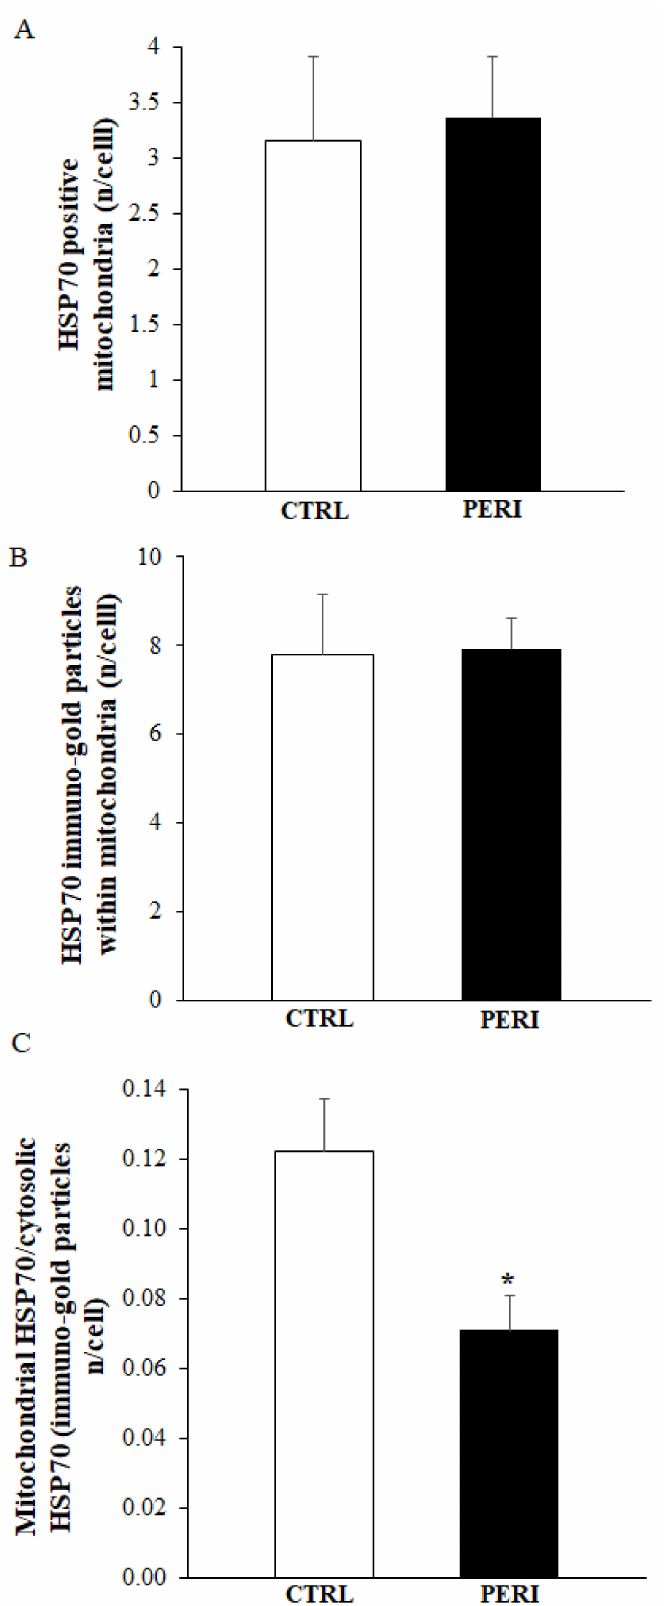
Figure 10. Polarization graphs for HSP70 within mitochondria in the ventral cerebral cortex. Graphs report the HSP70-positive mitochondria ( A ), the HSP70 immuno-gold particles within mitochondria ( B ) and the ratio of mitochondrial to cytosolic HSP70 immuno-gold particles ( C ). * p ≤ 0.05 compared with the control